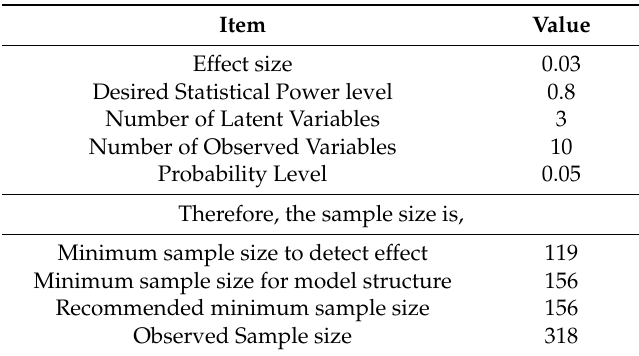
Table 5. Sample size calculation (Source: Sample